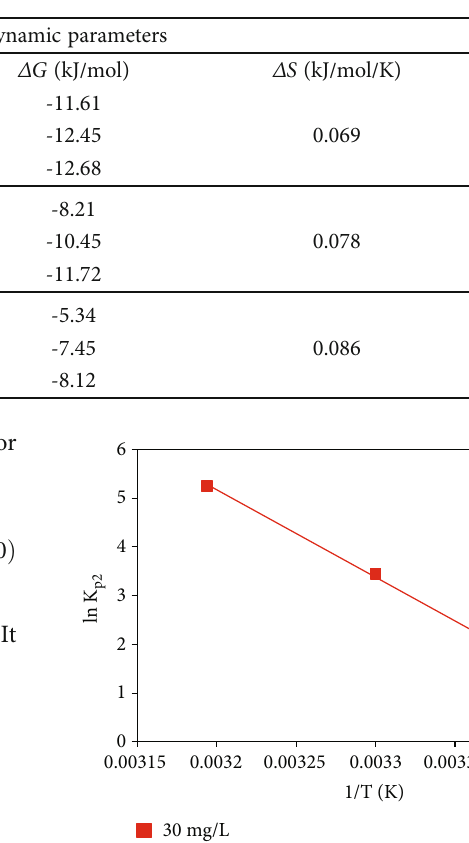
Table 8: Thermodynamic parameters for CV removal onto ACMAS.